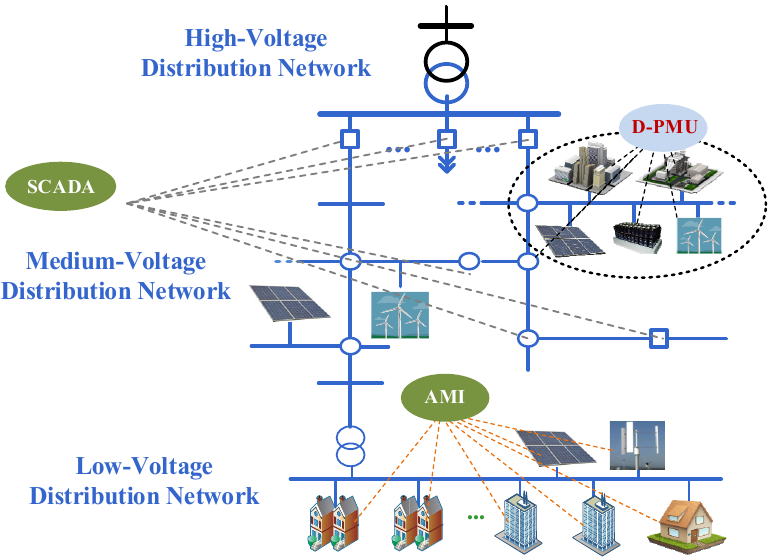
Figure 1. The structure of the existing measurement system.